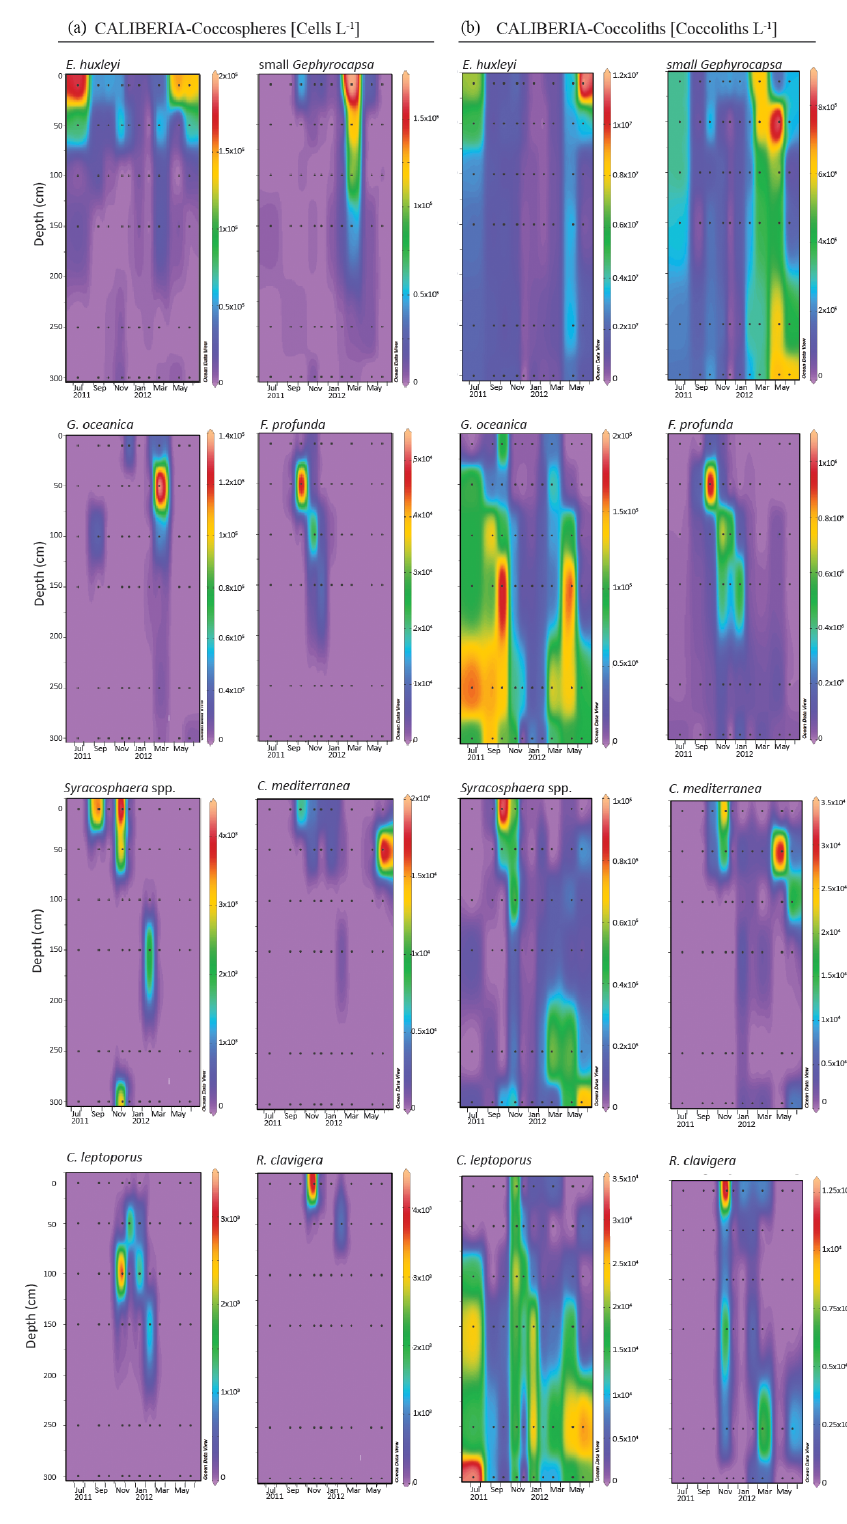
Figure 7. Absolute abundance of major species of coccospheres ( a , given in cellsL − 1 ) and coccoliths ( b , given in coccolithsL − 1 ) in CALIBERIA station. Black dots represent the sampling month and depth. Note that each colour bar has been scaled to the maximum and minimum values of its corresponding